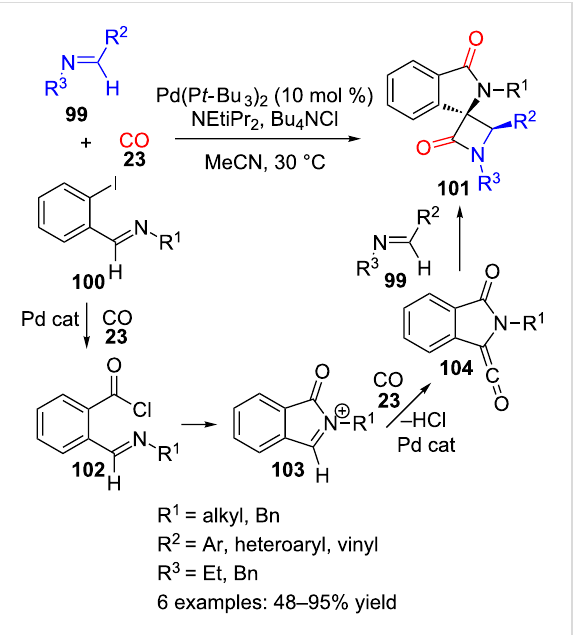
Scheme 29: Palladium-catalysed three-component reaction of imines 99 with CO ( 23 ) and ortho -iodoarylimines 100 .